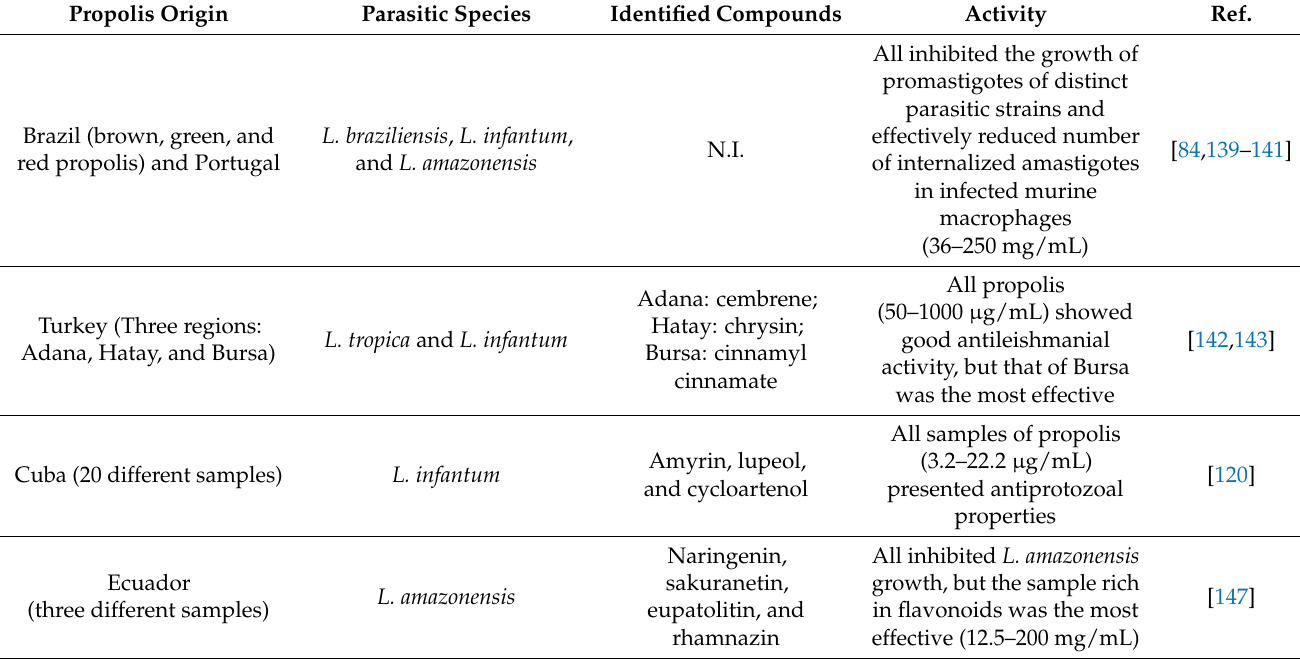
Table 13. Antileishmanial activity of various propolis and its chemical